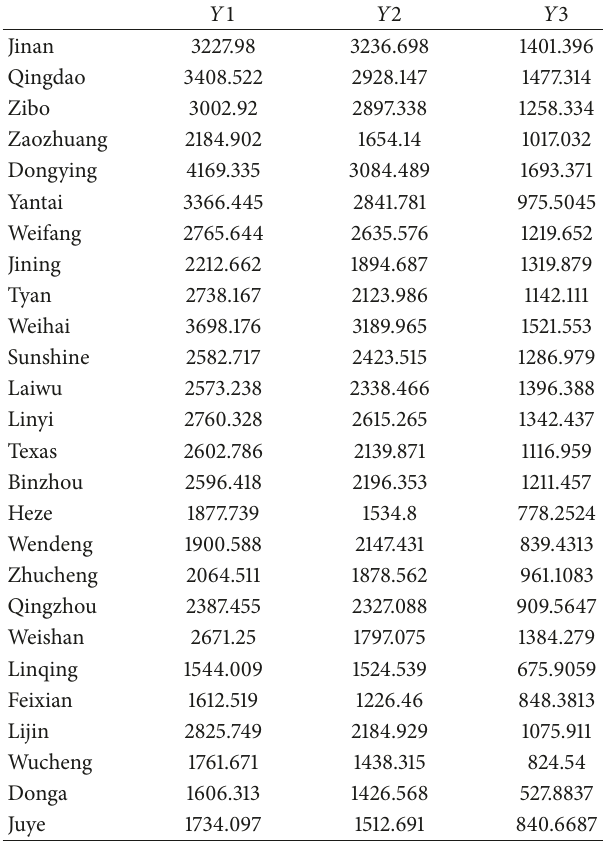
Table 4: The value of the main component into each